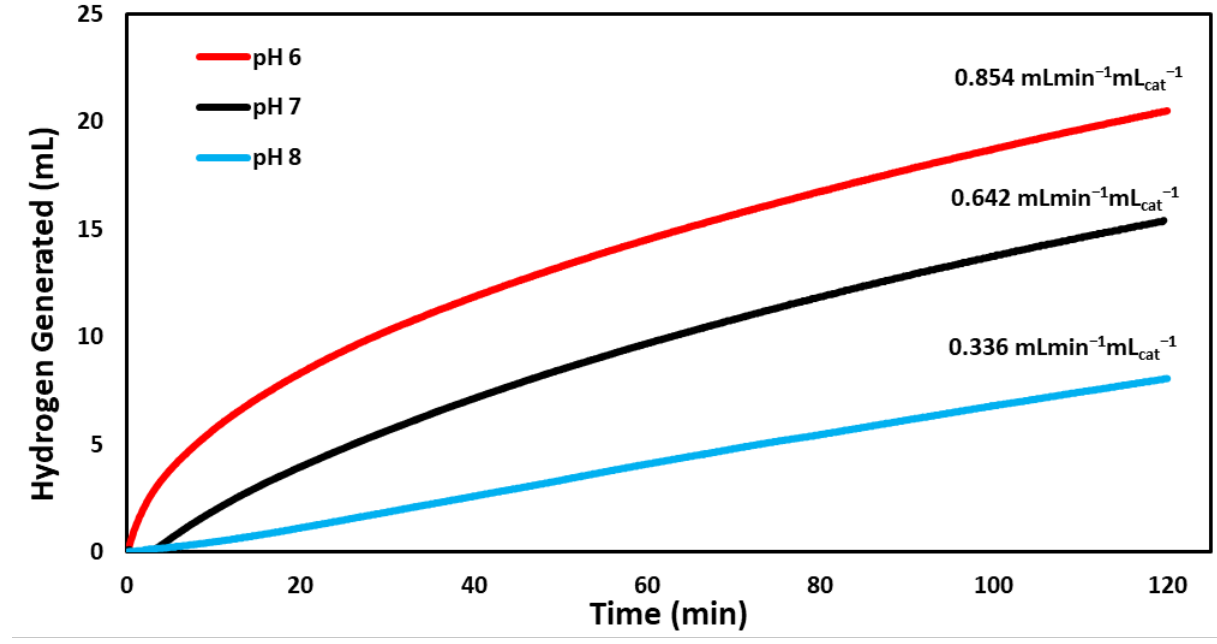
Figure 7. Volume of hydrogen gas generated versus time as catalyzed by the BCD − AuNPs under varied pH conditions (pH 6, 7, 8). The reactions were run at 295 K with 925 µmoles of NaBH 4 for approximately 120 min.